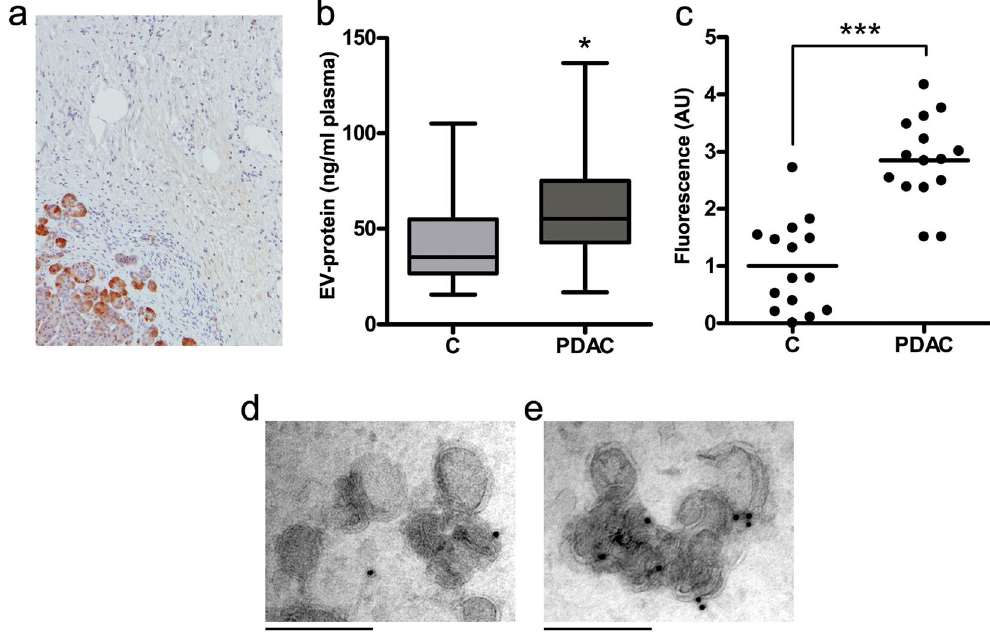
Figure 5. REG3 β + EVs are released to bloodstream in PDAC patients. ( a ) Immunolocalization by immunohistochemistry of REG3 β in human PDAC. REG3 β is absent in tumor cells but strongly expressed by the healthy acinar cells surrounding the tumor. ( b ) Quantification of EV levels in plasma through a Bradford assay. Circulating EVs were isolated from samples of healthy donors (C) (n = 15) and PDAC patients (n = 15). Data are expressed as mean ± SEM. Student’s t-test used to calculate P -values. * P < 0.05. ( c ) Human PKH26- labeled EVs (1 ng/ µ l of EV protein) binding to plates coated with anti-REG3 β antibody. Data are depicted as PDAC EVs binding levels relative to healthy donors samples. Significance determined using a two-tailed Mann– Whitney U test. *** P < 0.001. ( d , e ) Representative immunogold labeling of EVs from healthy donors (D) or PDAC patients (E) with anti-REG3 β . Scale bars: 200